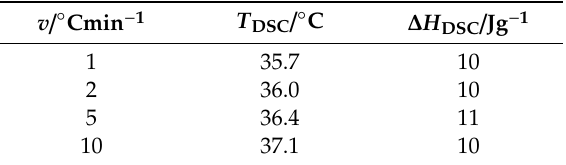
Table 2. Heating rate ( v ), transition temperature determined by DSC ( T DSC ) and transition enthalpy per unit mass of polymer network determined by DSC ( ∆ H DSC ).